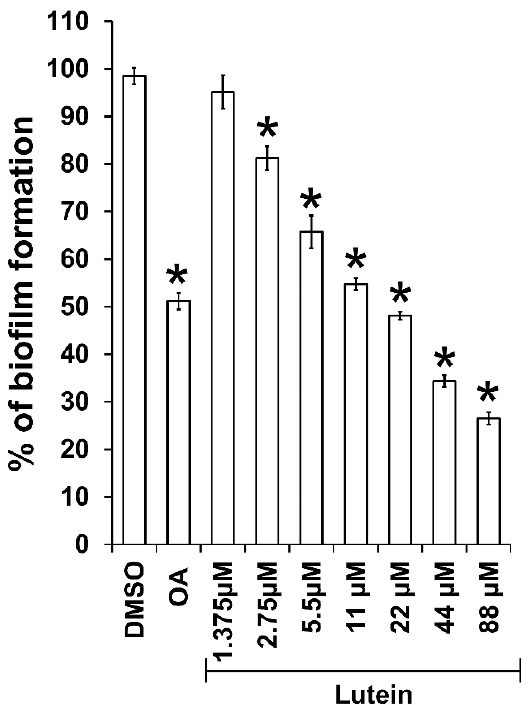
Figure 2. Dose-dependent anti-biofilm activity of Lut. The biofilm formation of P. aeruginosa PAO1 grown in minimal medium supplemented with DMSO 1%, oleanolic acid 800 µM (OA, as positive control) or different concentrations of Lut (from 1.375 to 88 µM) after incubation without agitation at 37 °C for 24 h. Biofilm formation was quantified by crystal violet staining and measured as A 590nm and expressed as % of biofilm formation. All experiments were performed in quintuplicate with three independent assays. Error bars represent the SEM; asterisks indicate samples that are signifi- cantly different from the DMSO ( p ≤ 0.01). Figure 3. Effect of Lut on the growth kinetics of PAO1. Growth kinetics of PAO1 in presence of Lut at 22 µM or DMSO 1% over a period of 22 h under agitation by measuring the cell density of the bacterial growth at A600 nm. The bars represent the standard error of the mean. There were no statistical differences between the 2 conditions at any time point (n = 4) ( p- values > 0.01).